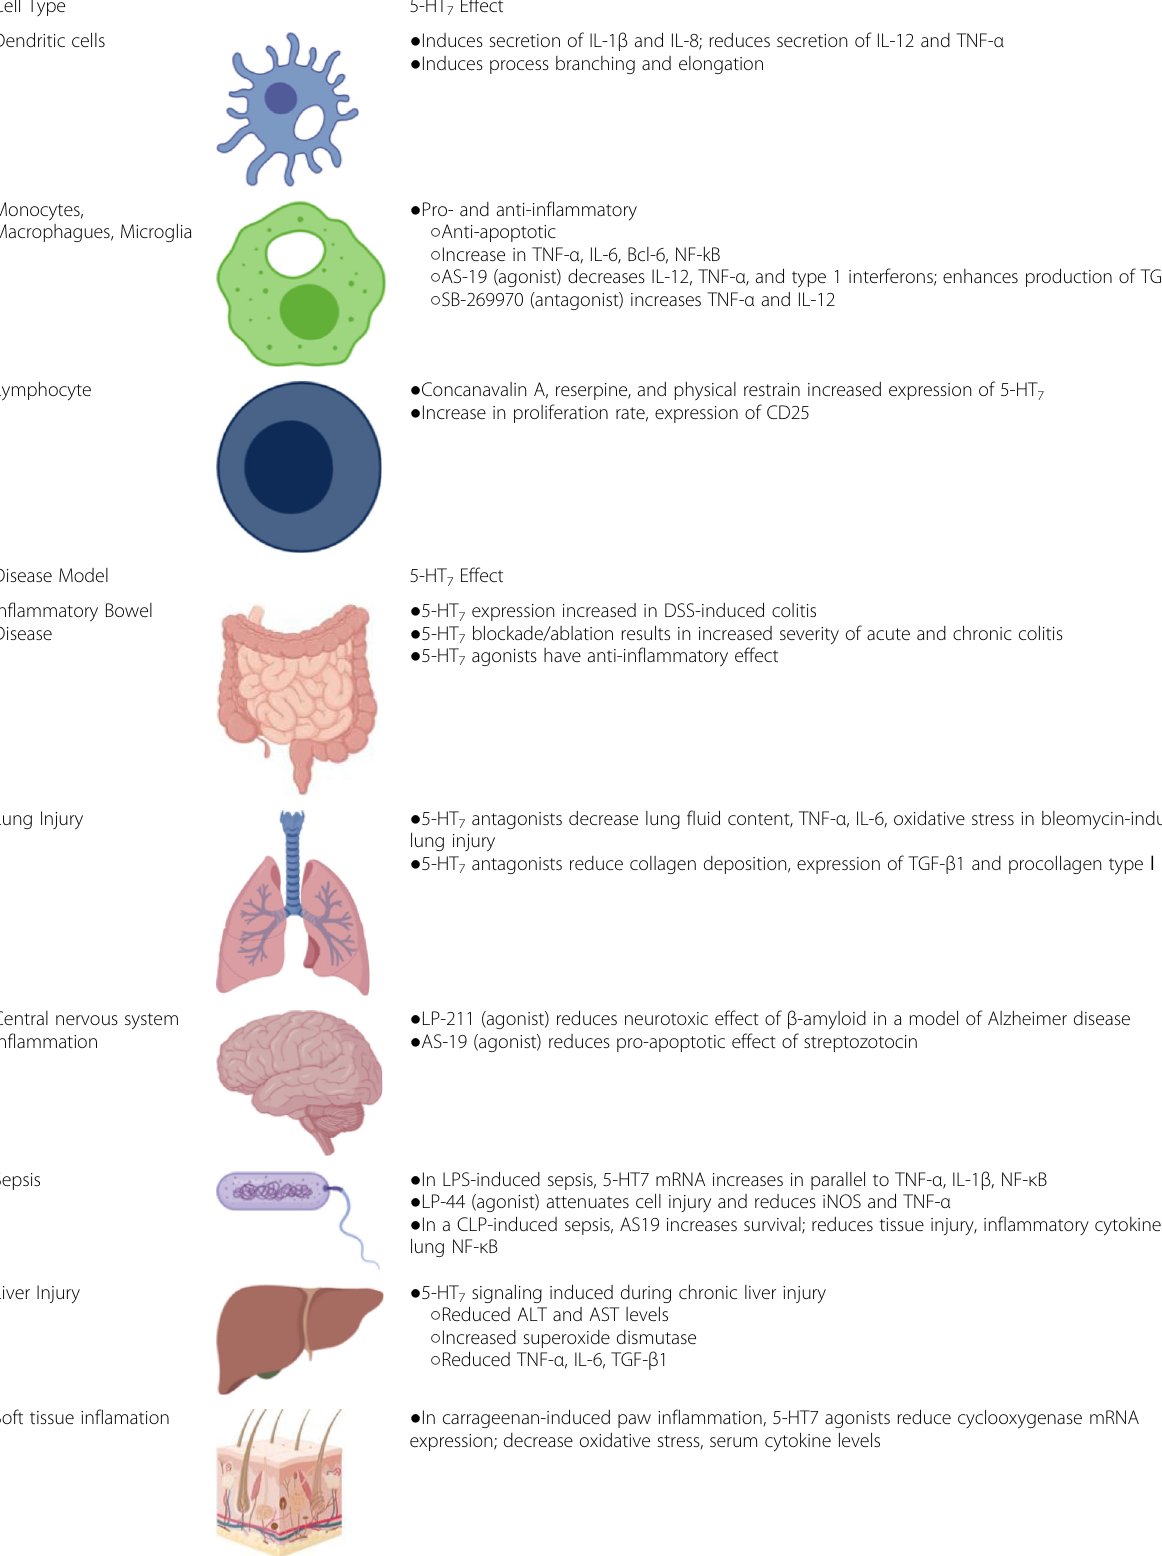
Table 1 Effect of 5-HT 7 receptor signaling on different immune cells and inflammatory conditions Cell